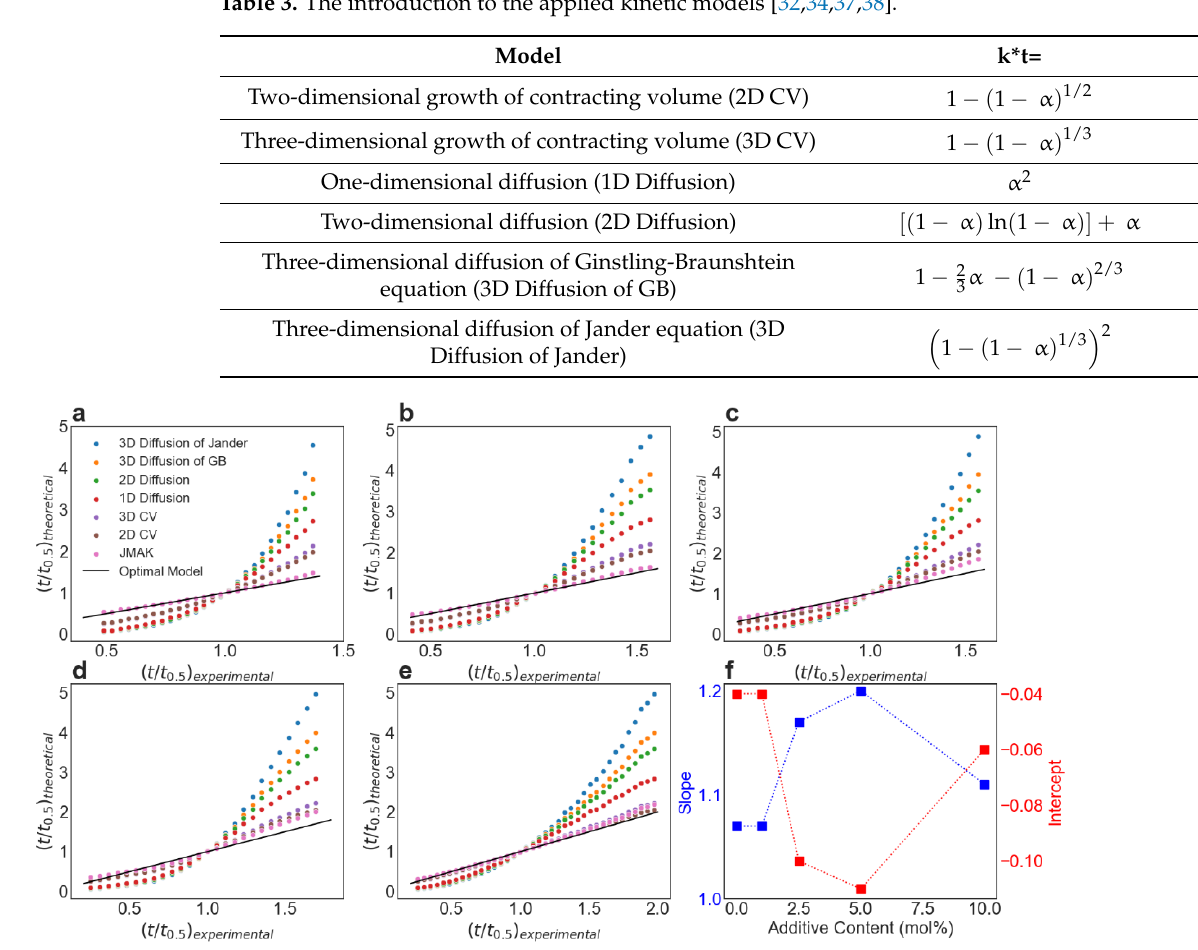
Figure 7. Comparison of different models for kinetic analysis: ( a – e ) Plots of (t/t 0.5 ) experimental vs. (t/t 0.5 ) theoretical based on the reduced time method for a variety of kinetic models in different scenarios with varying contents of additives (0, 1 mol%, 2.5 mol%, 5 mol% and 10 mol%). The optimal fitting is represented by the straight line for reference; ( f ) The corresponding slope and intercept for the JMAK model (with different Avrami exponents) according to the plots ( a – e ) indicates that the JMAK model describes the experimental data the best.